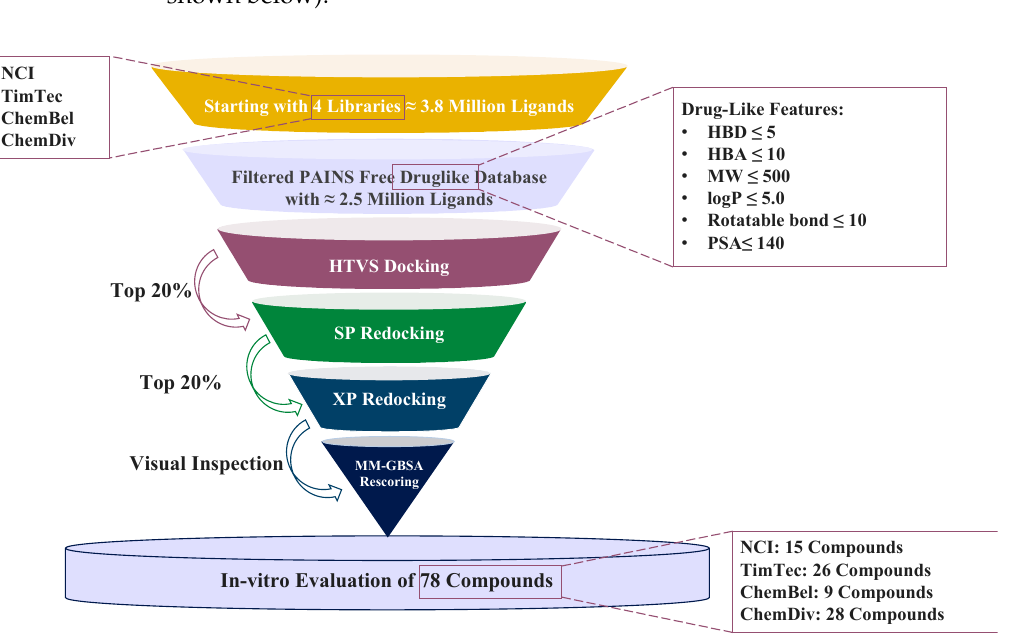
Table 1. Pharmacokinetics, drug-like, and lead-like characteristics of selected hits predicted by Swis- sADME.